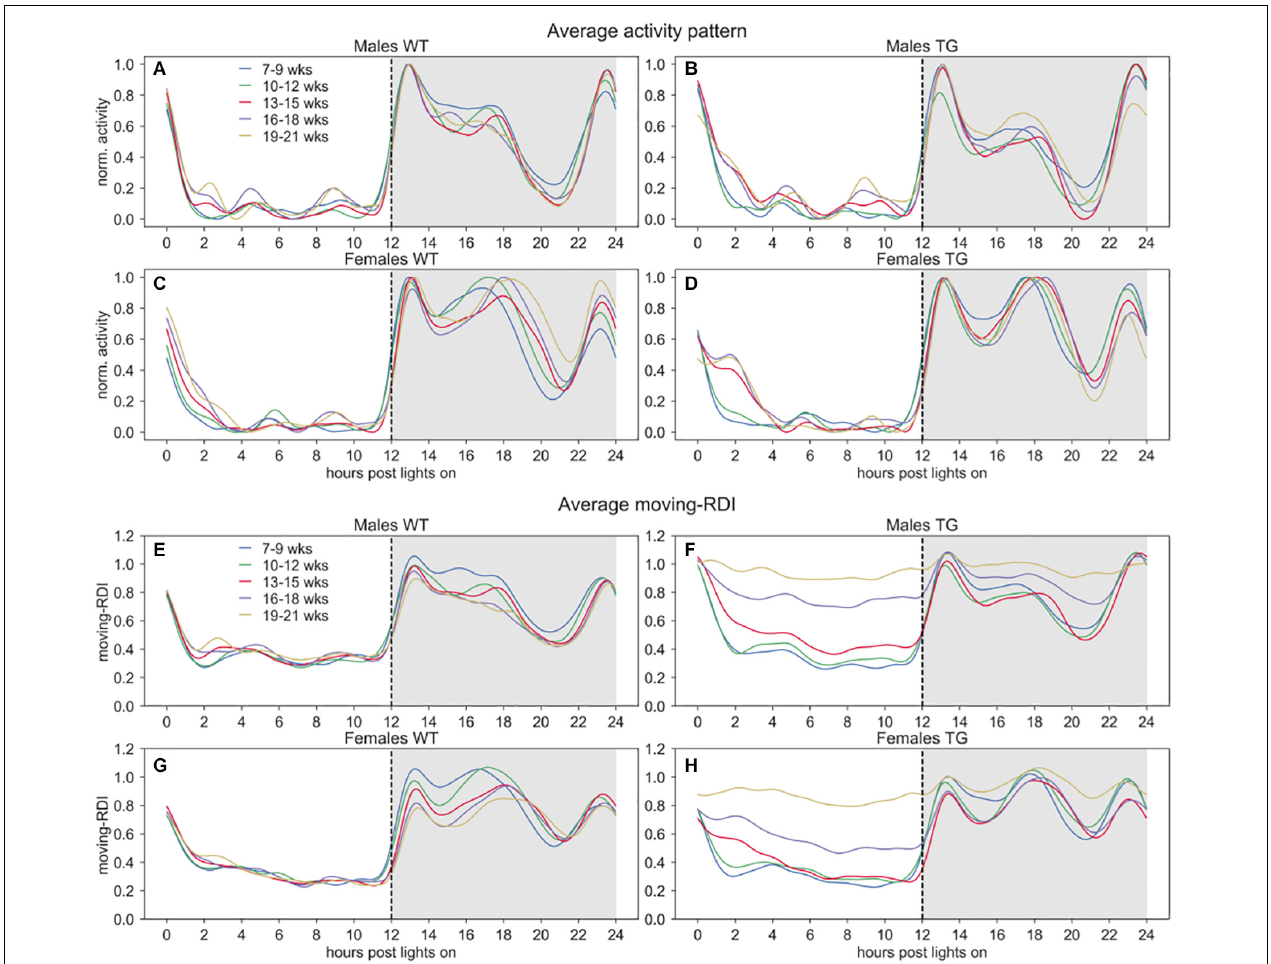
FIGURE 2 | Activity and moving-RDI patterns over 24 h. Panels (A–D) show the minute-based activity time series over 24 h, smoothed with a moving average of 60 min and normalized to peak activity (=1.0), then averaged across cages of the same group and weeks of the same 3-weeks period. Panels (E–H) show the central moving RDI computed on the minute-based activity with a sliding window of 60 min, then smoothed with a moving average of 60 min and averaged across cages of the same group and weeks of the same 3-weeks period. Lights-on at 07:00 AM (hour 0), lights-off at 07:00 PM (hour